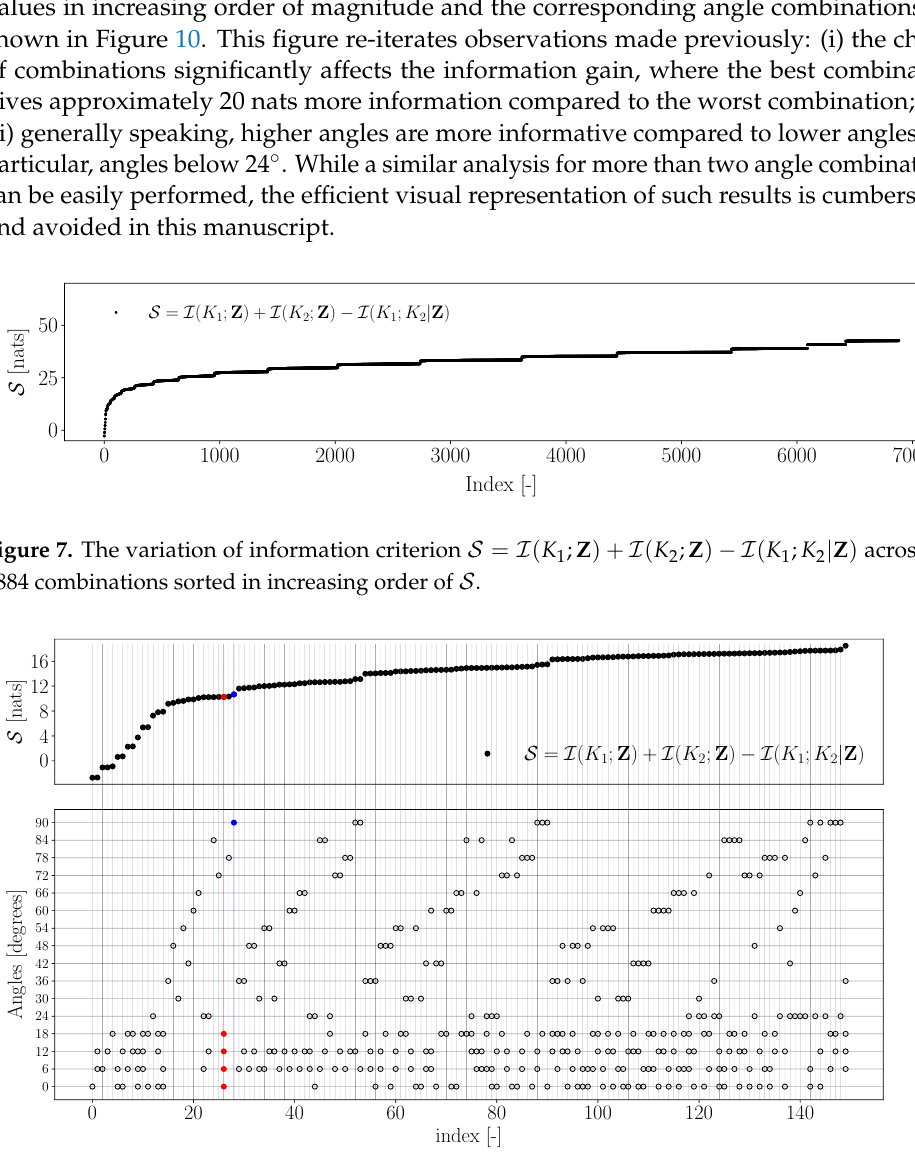
Figure 8. Zoomed view of the first 150 protocols from Figure 7. The upper panel shows lower panel shows the angles (by circles) in the corresponding protocol. The red points showcase a protocol with four measurement angles which yet produces a lower with respect to the blue points which show a protocol with only one measurement angle.